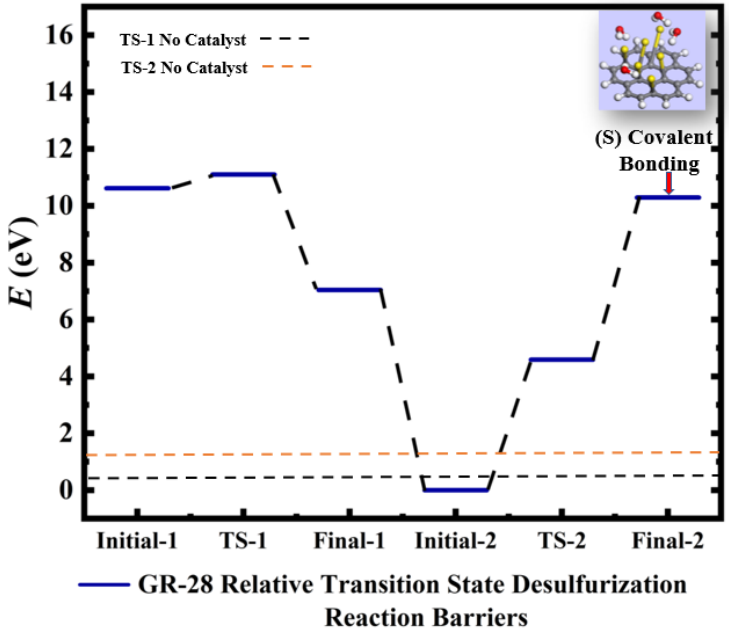
Figure 5. Calculated relative initial, transition, and final states reaction barriers of step 1 and step 2 for the oxidation–reduction of sulfur dioxide to elemental sulfur (S) by utilizing doubly-charged catalyst graphene flake (GR-28) represented by the blue bars. Light blue inset: geometrically optimized final state 2 (Final-2) of GR-28 with covalent bonded atomic S surrounded by 4 molar H 2 O. Sulfur, carbon, oxygen, and hydrogen are represented by the yellow, gray, red, and white spheres, respectively.